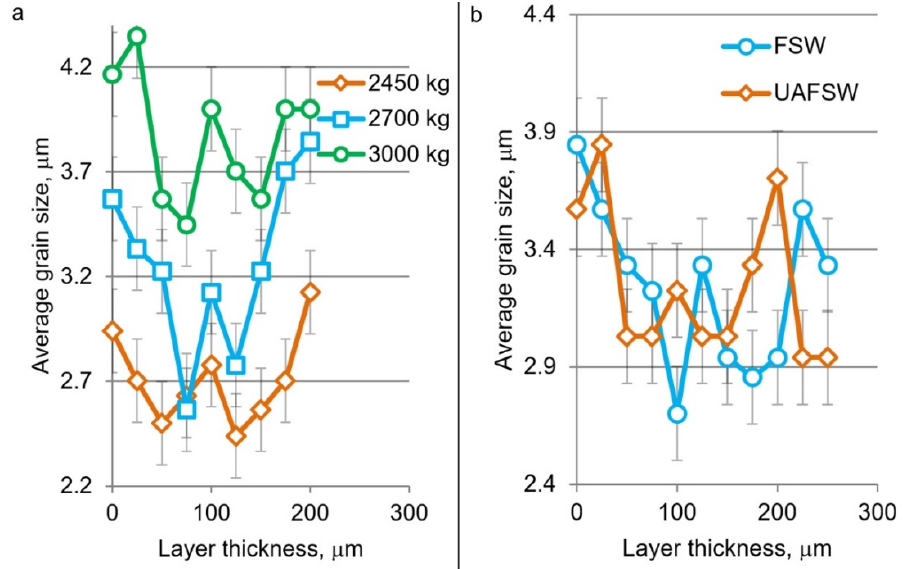
Figure 5. Results of grain size measurements in the transfer layer depending on the axial load ( a ) and at the influence of ultrasound ( b ).